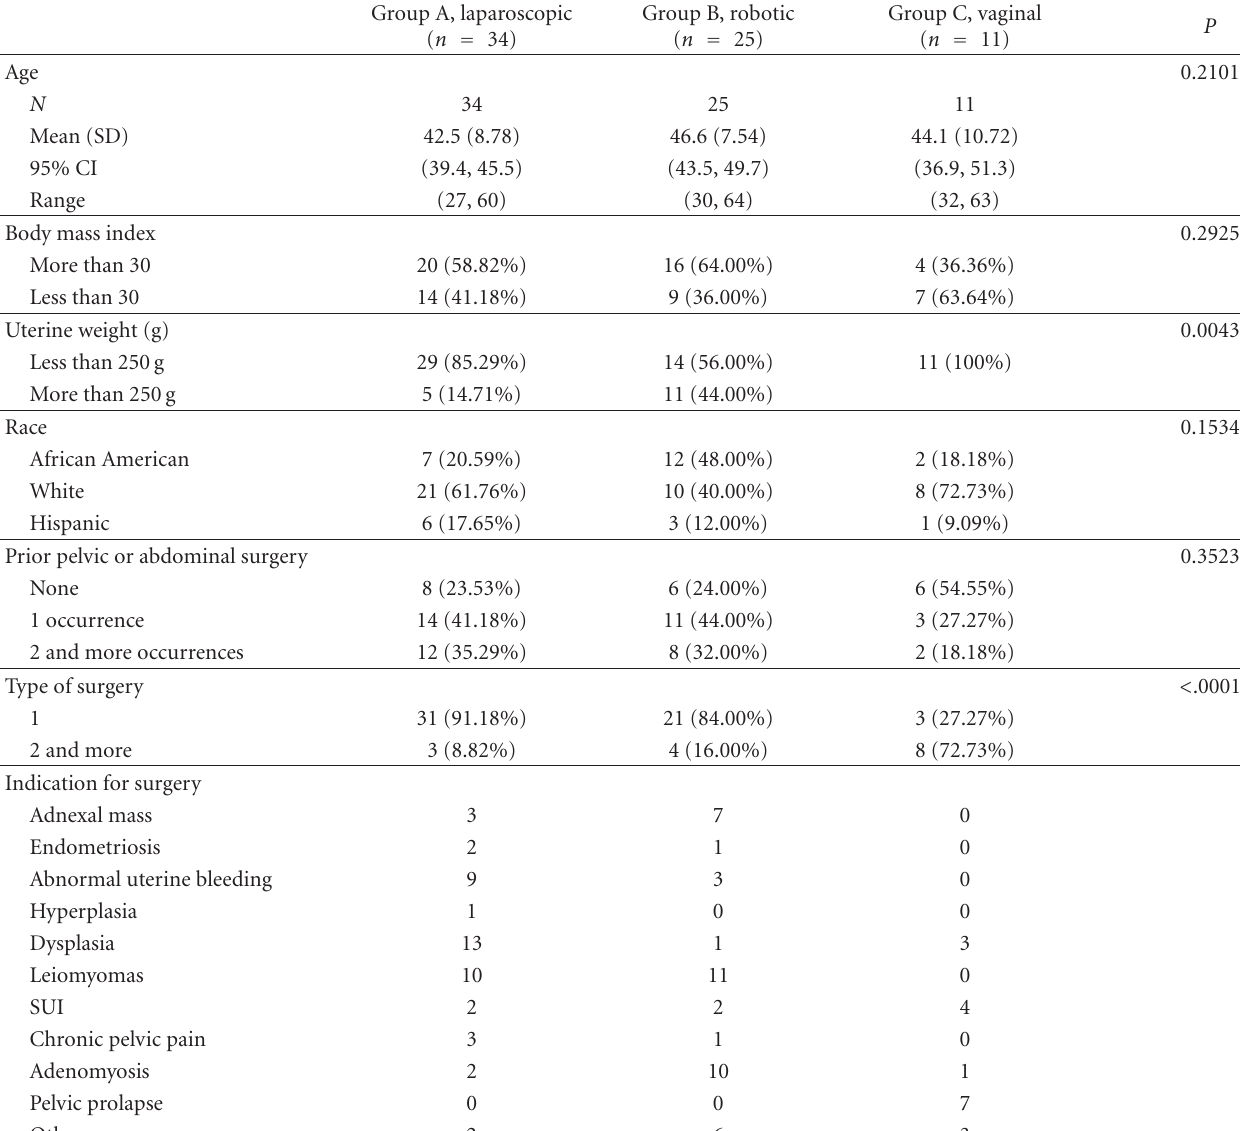
Table 1: Preoperative